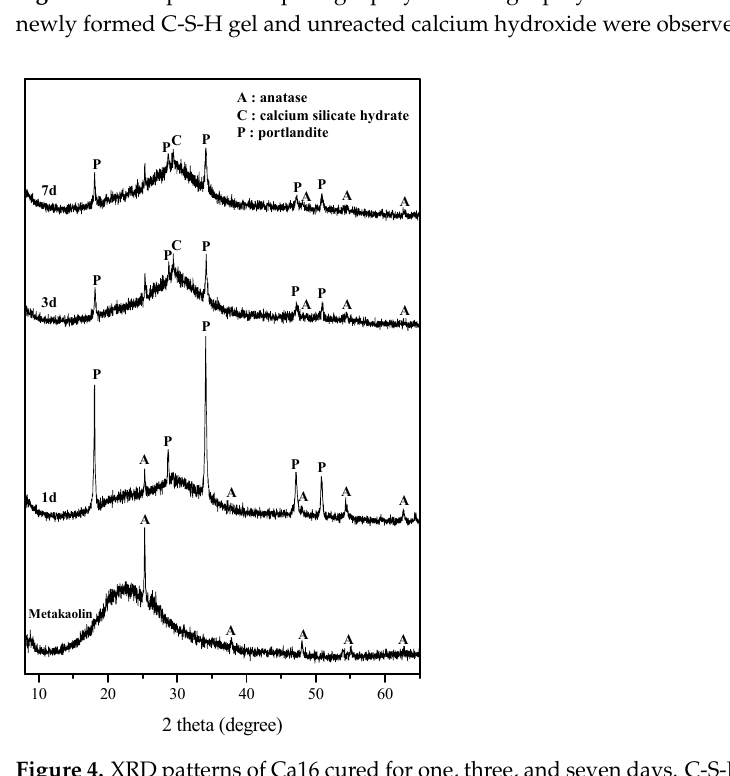
Figure 4. XRD patterns of Ca16 cured for one, three, and seven days. C-S-H gel is rapidly precipitated at the early stage of reaction and some of the calcium hydroxide remains intact.